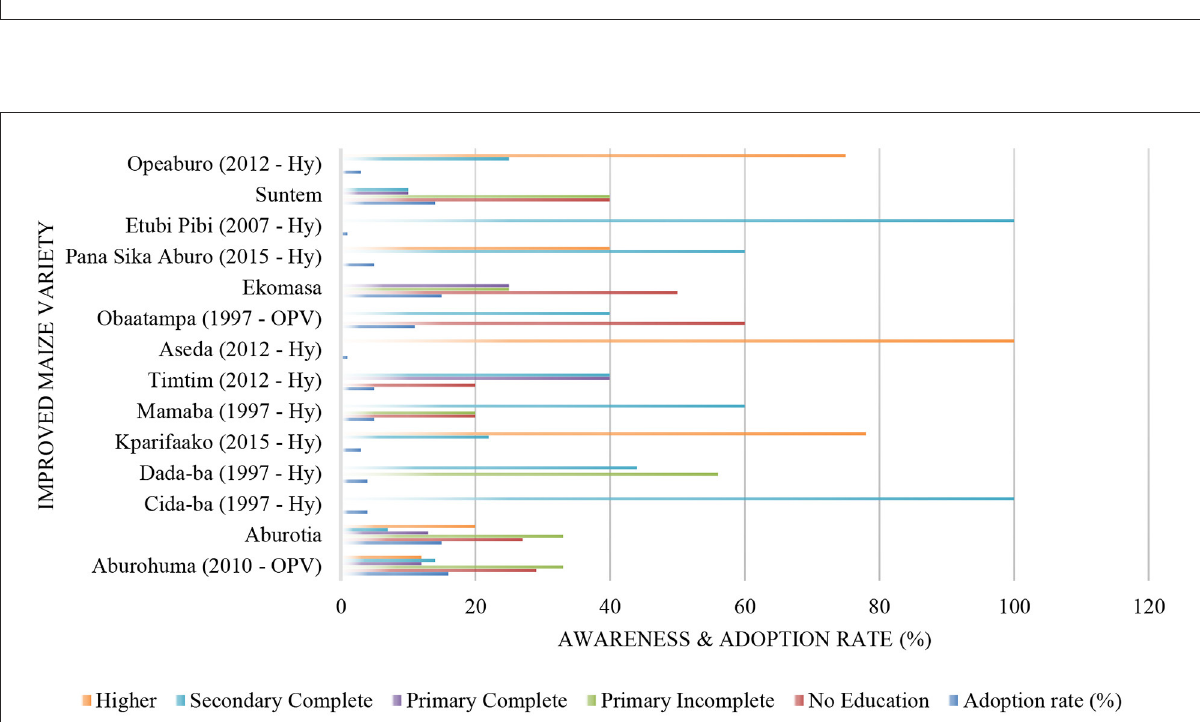
FIGURE3 Distribution showing improved maize variety and adoption rate per gender. Hy, Hybrid; OPV, Open Pollinated Varieties. This figure compares the overall adoption rate of improved seeds with the adoption rate of male and female. Author, 2021.